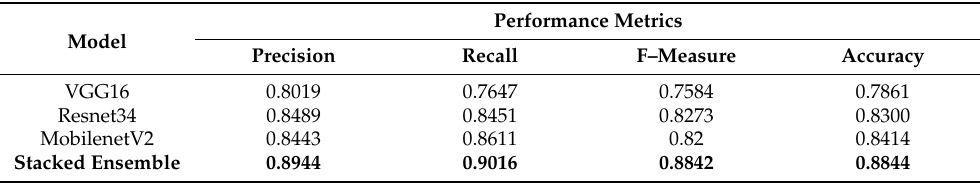
Table 4. Comparison of results achieved for various base-learners in combination with proposed classifiers. Best results achieved using the Stacked Ensemble model is indicated in bold.